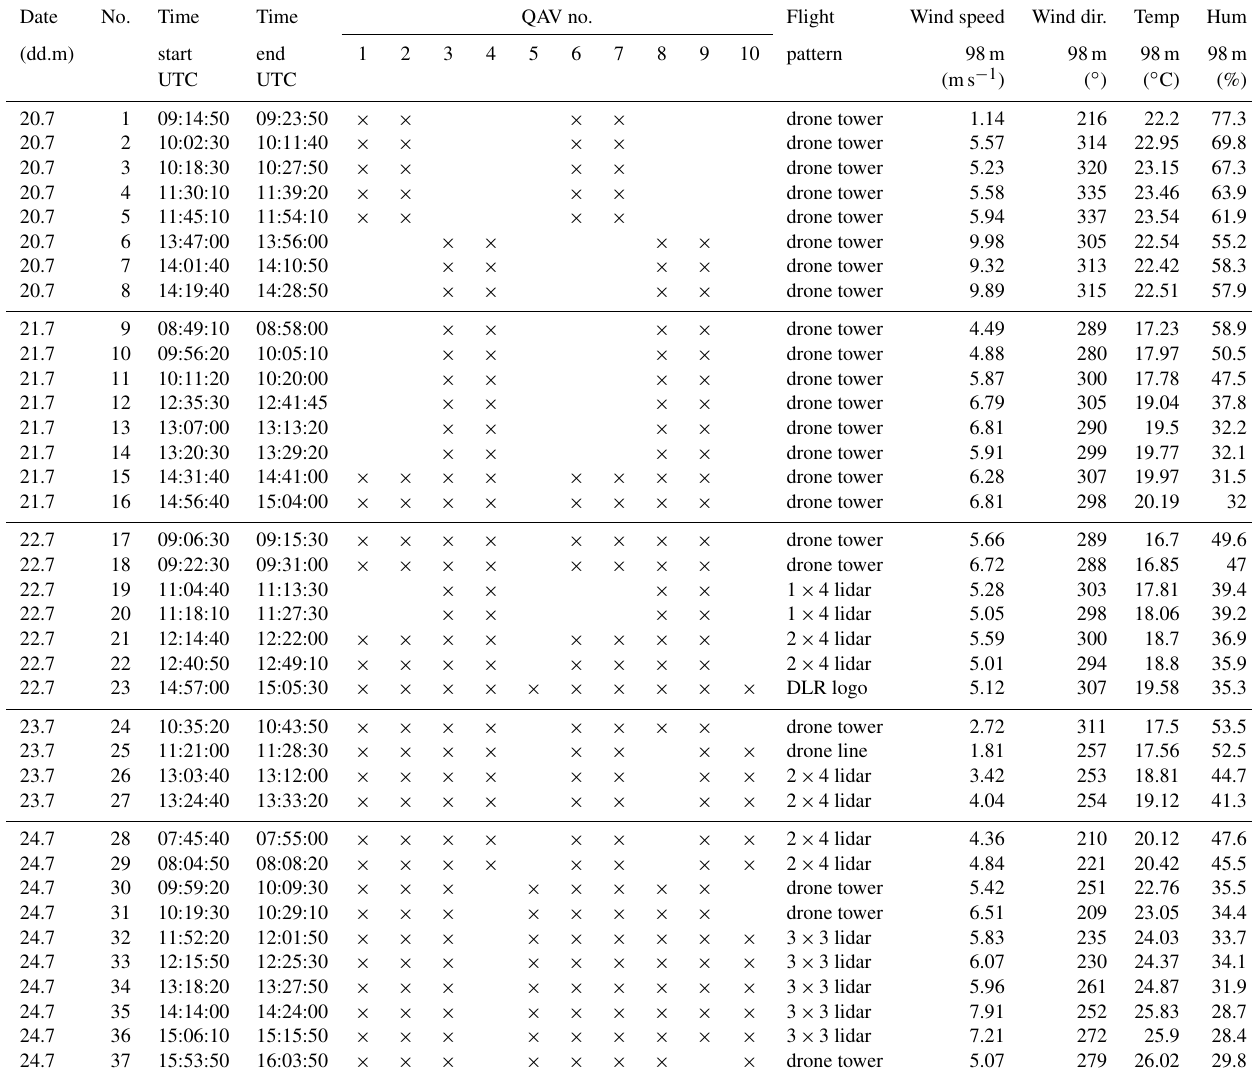
Table E1. Flight protocol of the first week of the FESST@MOL